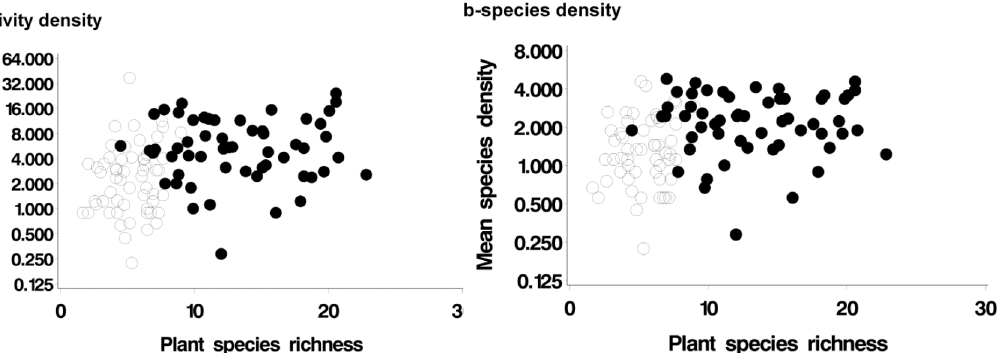
Fig 4. (a) Hunting spider activity density and field plant species richness (before harvest). Organic farms shown as solid points. Upward trend in conventional farms (open points, model averaged parameter estimate 0.10, SE = 0.05, P = 0.04), no trend among organic farms (model averaged parameter estimate 0.02, SE = 0.02, P = 0.29). (b) Hunting spider species density and field plant species richness (before harvest). Organic farms shown as solid points. Upward trend in conventional farms (open points, model averaged parameter estimate 0.05, SE = 0.03, P = 0.06), no trend among organic farms (model averaged parameter estimate 0.005, SE = 0.01, P =